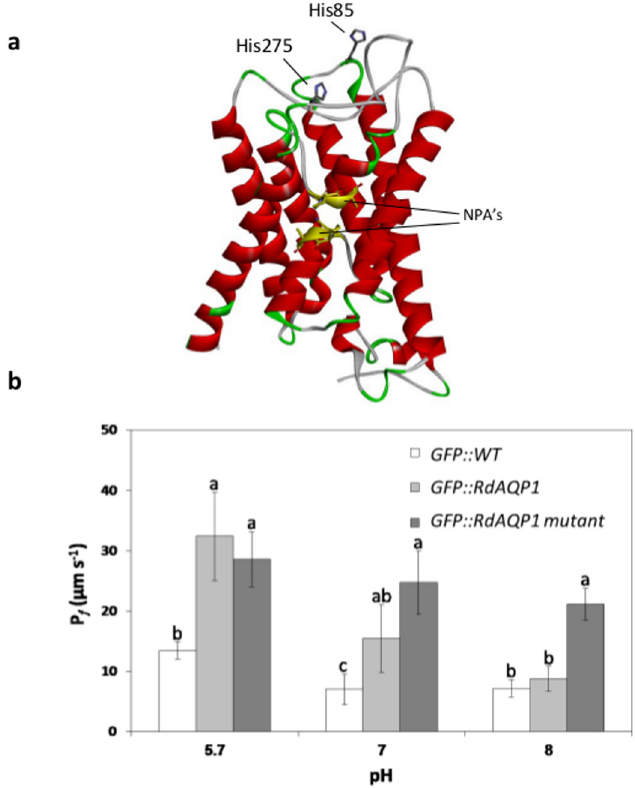
Fig 7. The role of the outer cell His residues in pH sensing. (a) Predicted three-dimensional structure of RdAQP1 showing two His residues (His85 and His275) positioned on the loops of the protein and facing the outside of the cell. (b) P f values of GFP::WT (wild type), GFP::RdAQP1 and GFP::RdAQP1 mutant,. Different lowercase letters above the bars denote significant differences for each pH level between fungal types ( P <